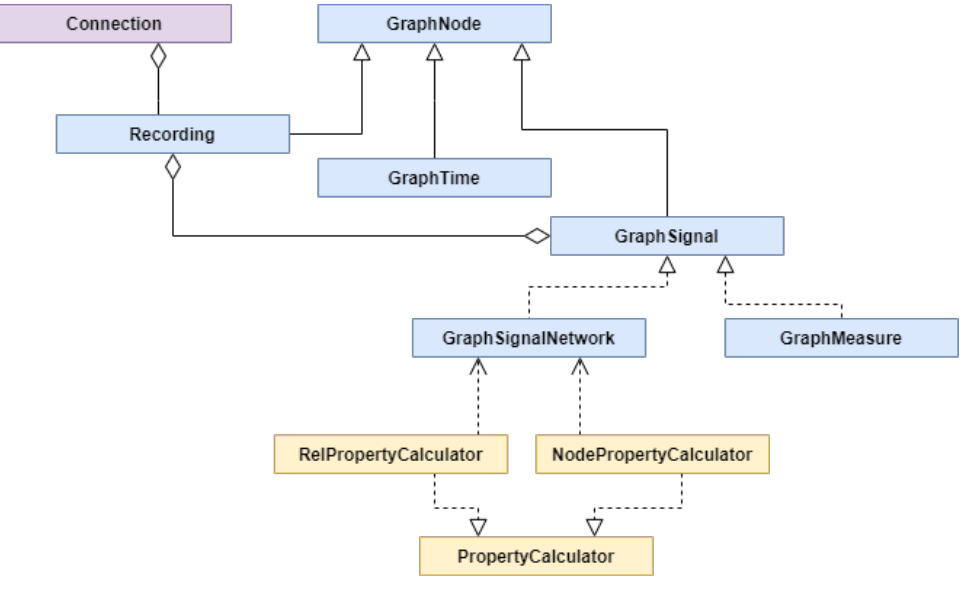
Figure 8. UML class diagram.